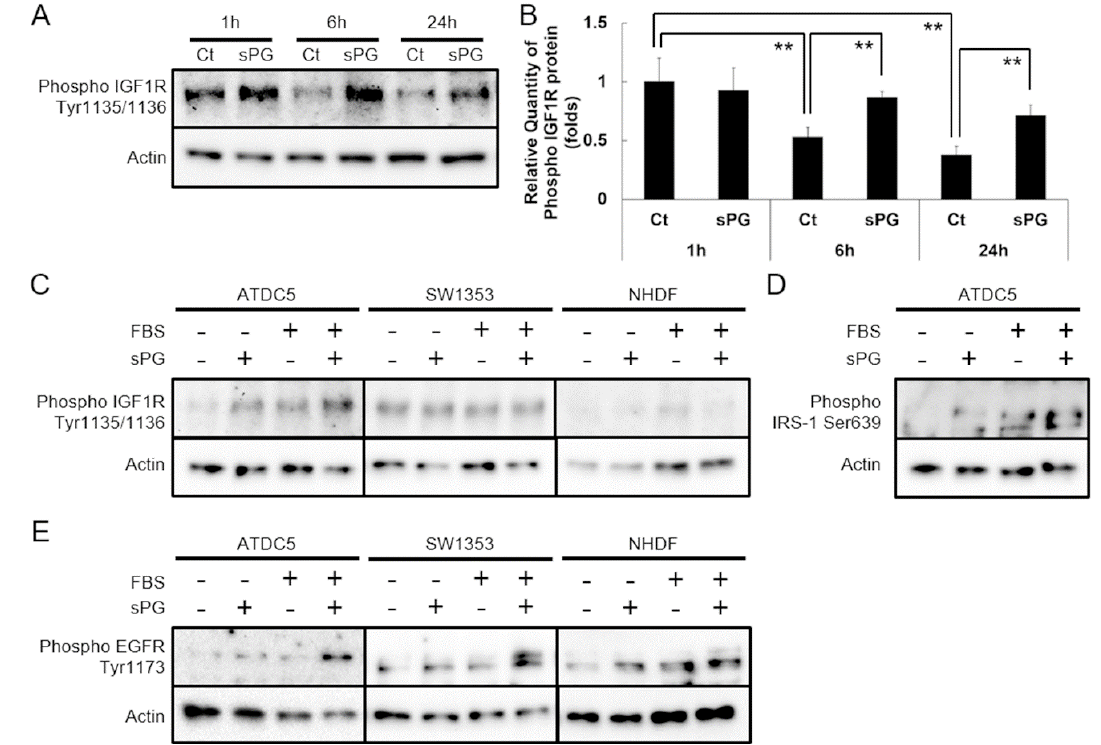
Figure 2. E ff ects of sPG on phosphorylation of Insulin-like Growth Factor-1 Receptor (IGF-1R) and Epidermal Growth Factor Receptor (EGFR) in cell proliferation. ( A ) Immunoblotting analysis on phosphorylation of IGF-1R in cell proliferation. ATDC5 cells were treated without (Ct) or with sPG (100 µ g / mL) under DME / F12 medium containing 0.5% FBS without insulin for 1, 6, 24 h at 37 ◦ C in a humidified atmosphere of 5% CO 2 in air and harvested. Phosphorylation of IGF-1R were analyzed by immunoblotting with phospho-IGF-1R antibody. ( B ) Densitometric analysis of phospho-IGF-1R bands. The obtained bands were densitometrically analyzed by Image J and normalized relative to β -actin, as shown in the graph. E ff ects of sPG on phosphorylation of IGF-1R ( C ) and EGFR ( E ) in di ff erent cell types. ATDC5, SW1353 and NHDF cells were treated without or with sPG (100 µ g / mL) under each medium containing FBS-free or 0.5% FBS for 24 h at 37 ◦ C in a humidified atmosphere of 5% CO 2 in air and harvested. Phosphorylation of IGF-1R or EGFR was analyzed by immunoblotting with phospho-IGF-1R antibody or with phospho-EGFR antibody. Phosphorylation of insulin receptor substrate-1 (IRS-1) ( D ) with ATDC5 was analyzed by immunoblotting with phospho-IRS-1 antibody. These data are presented as the mean ± S.D. of three independent experiments. Significant di ff erences show ** p < 0.01; Tukey (cid:48) s